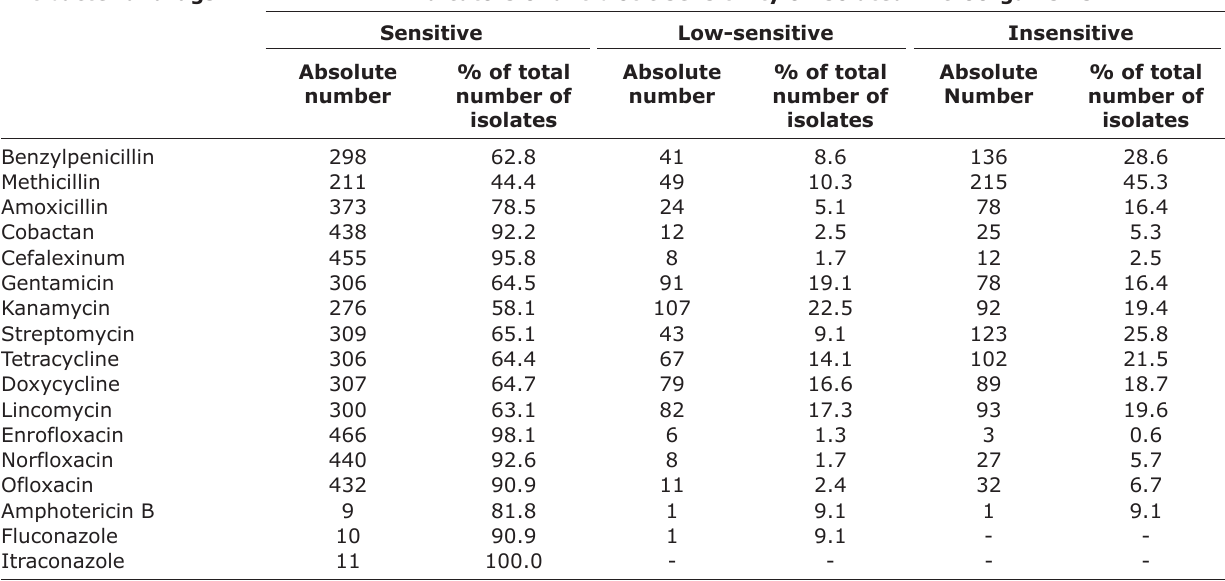
Table-7: Results of determining the sensitivity of isolated microorganisms in mastitis in cows to antibiotics and antimycotics. Antibacterial